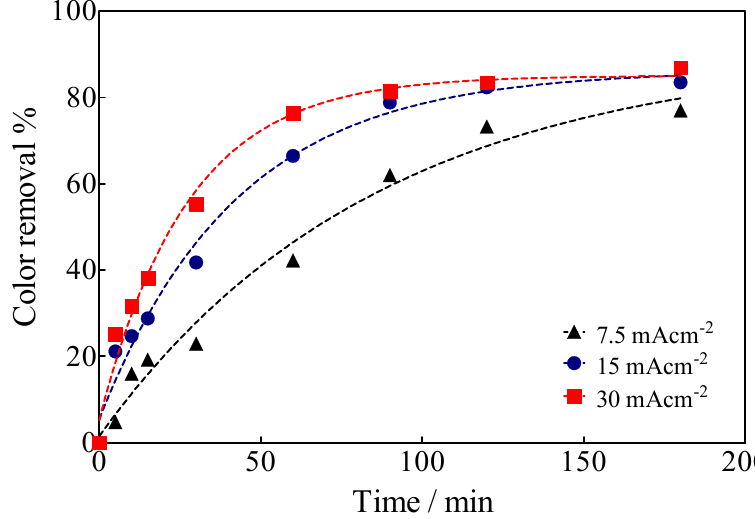
Figure 7. Color removal efficiency as a function of the electrolysis time and the applied current density for the EO of Calcon at BDD anodes in 0.25 M H 2 SO 4 .